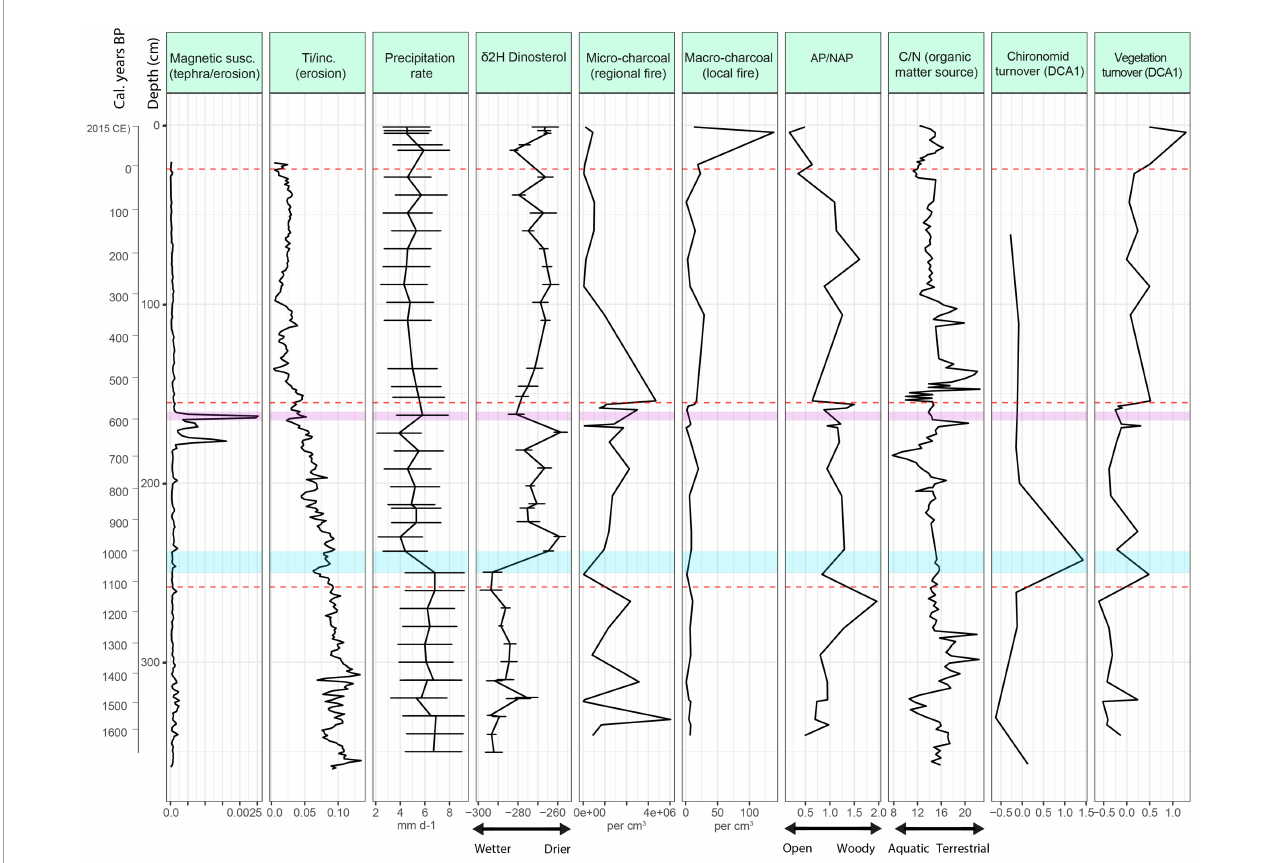
FIGURE5 Summary diagram of methods used in the study. From left to right: magnetic susceptibility (tephra/erosion), Ti/incoherent scatter (erosion), reconstructed precipitation rate mm day - 1 and 2 H dinosterol all redrawn from Maloney et al. (2022). What follows is new data from this study; micro- and macro charcoal particle concentrations per cm 3 , indicating regional and local fires. Arboreal pollen/non-arboreal pollen ratio (AP/NAP) indicating forest openness, C/N indicating organic matter source, and chironomid and vegetation turnover (DCA axis 1 scores). The purple shaded area represents samples where Kuwae volcanic tephra is present. The blue shaded area represents the transition from wetter to drier conditions during the onset of the 1100 cal. years BP shift to drier climate conditions. The red dashed lines are consistent with zonal divisions within the pollen diagram. The mean temporal resolution, where 1 cm of sediment represents 5 years (1–8 years range) for all the palaeoecological proxies is shown in the Supplementary Information . The mean error for each 1 cm slice of the core was 140 years (95% confidence ranges, see Supplementary Information